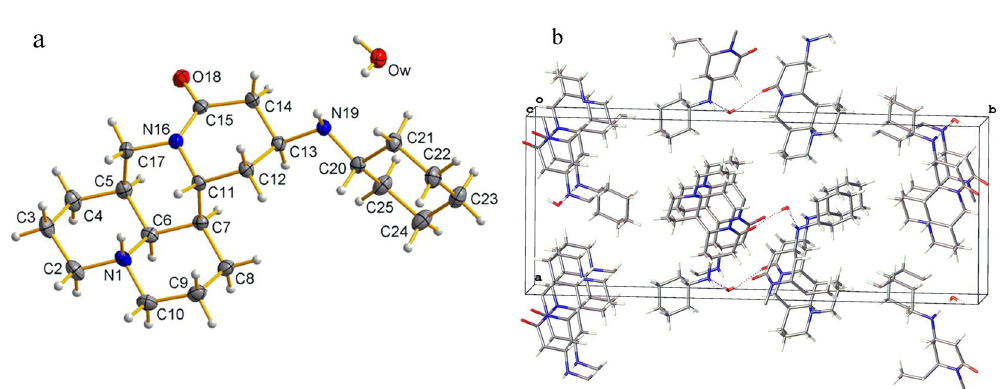
Figure 6. Crystal structure of matrine derivative 2 ( a ) and packing of its molecule in a unit cell ( b